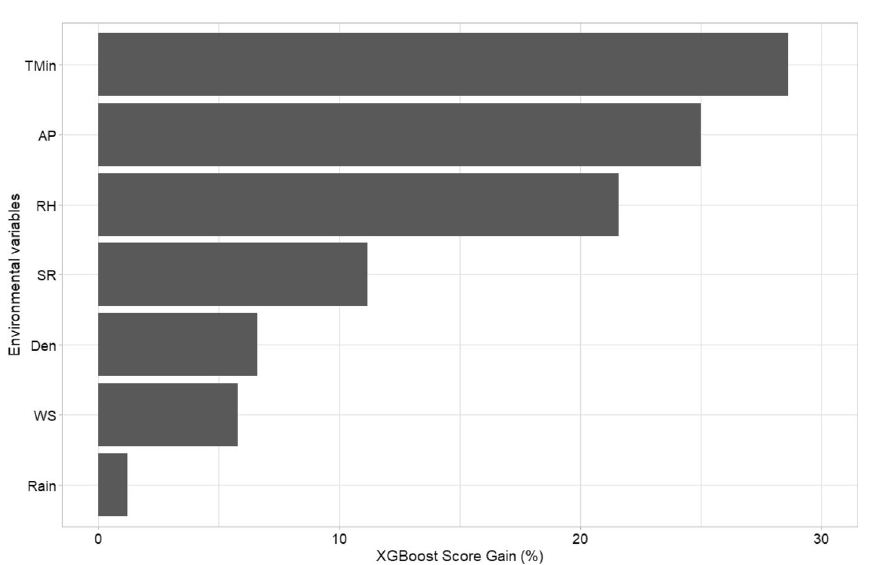
Figure 3. Top 7 most important variables based on the Gain Score (impurity) metric. TMin = Minimum atmospheric temperature; AP = Atmospheric pressure; RH = Relative humidity; SR = Ultraviolet solar radiation; Den = Population density; WS = Wind speed; Rain = Accumulated